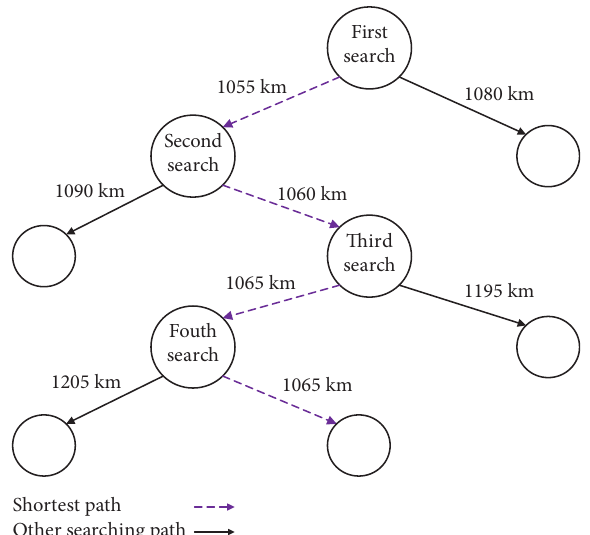
Figure 15: Search path F ( n ) from Algiers to Rome.